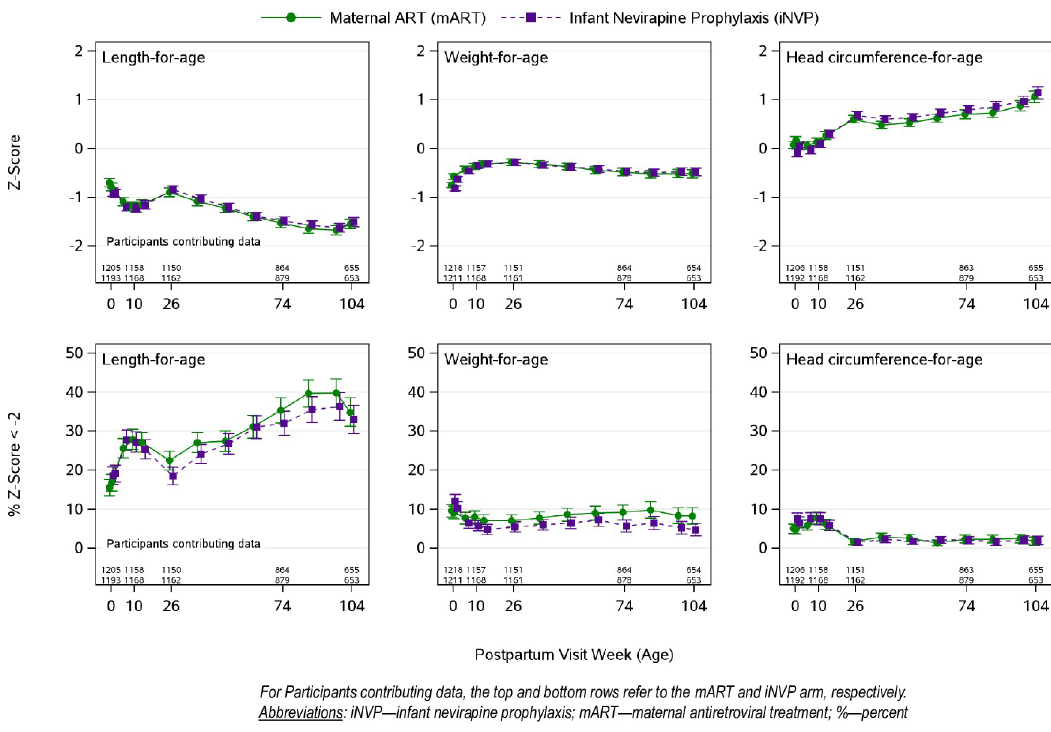
Fig 2. Infant growth outcomes by assigned study